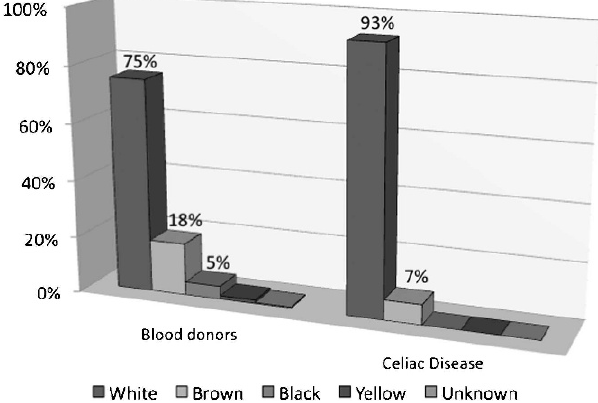
Figure 1 - Ethnic distribution in the study population with and without